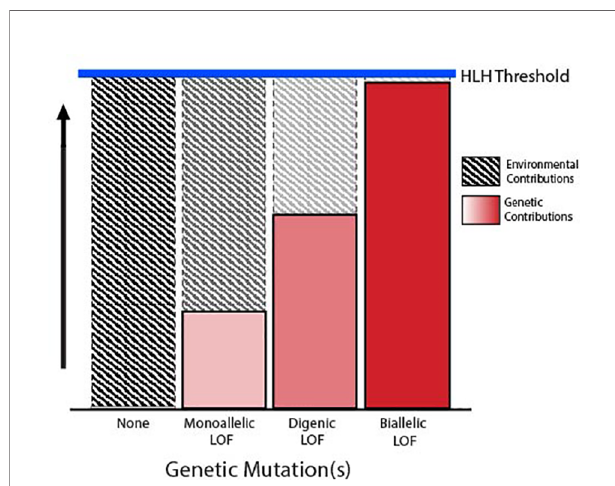
FIGURE 2 | Threshold model of HLH. Schematic depicting the inverse relationship between the degree of degranulation pathway dysfunction conferred by germline variants and the environmental trigger required to reach the threshold for development of